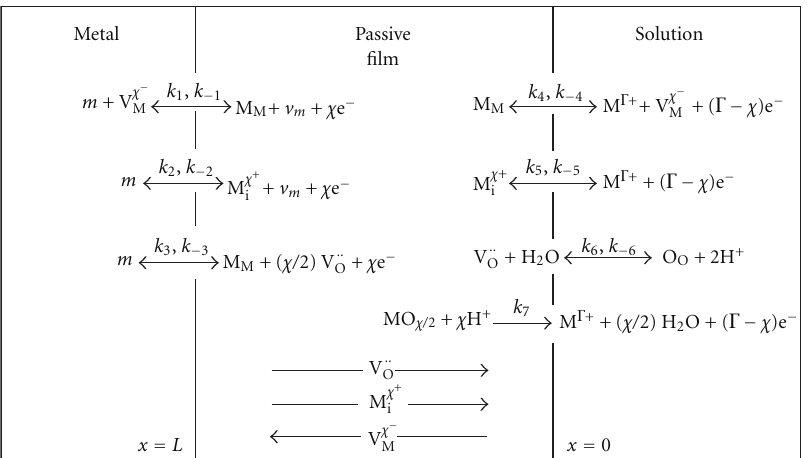
= interstitial cation, M M i = oxygen O